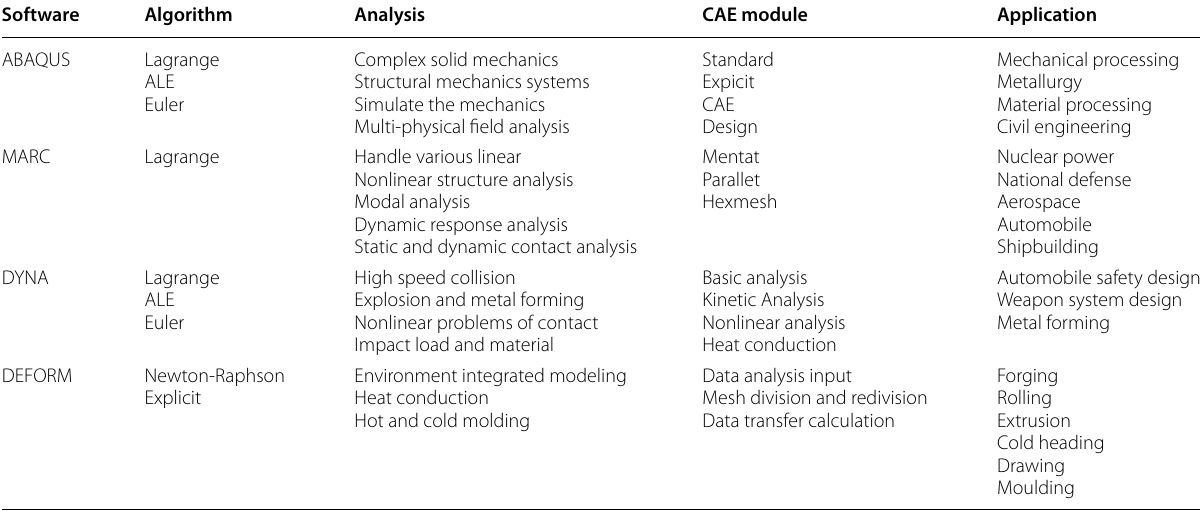
Table 2 Comparison of common cutting process simulation softwares